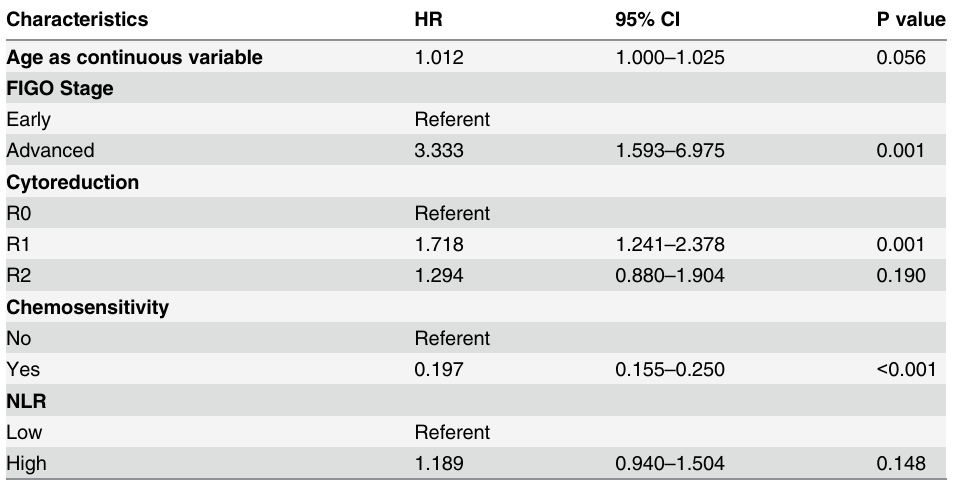
Table 4. Multivariable analysis of factors associated with